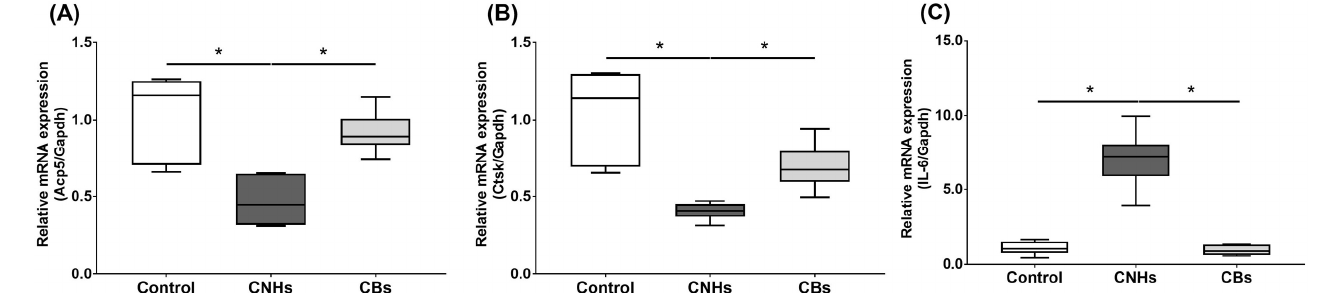
Figure 5. Effects of CNMs on gene expression in OCs. The OCs were exposed to CHNs and CBs. The relative amounts of Acp5 ( A ), Ctsk ( B ), and IL-6 ( C ). mRNAs were analyzed using quantitative real-time PCR (n = 6 cultures each). The horizontal line in each box indicates the median, the box shows the interquartile range (IQR), and the whiskers are 1.5 × IQR. Statistical significance was evaluated using the Steel–Dwass test. * p < 0.05.